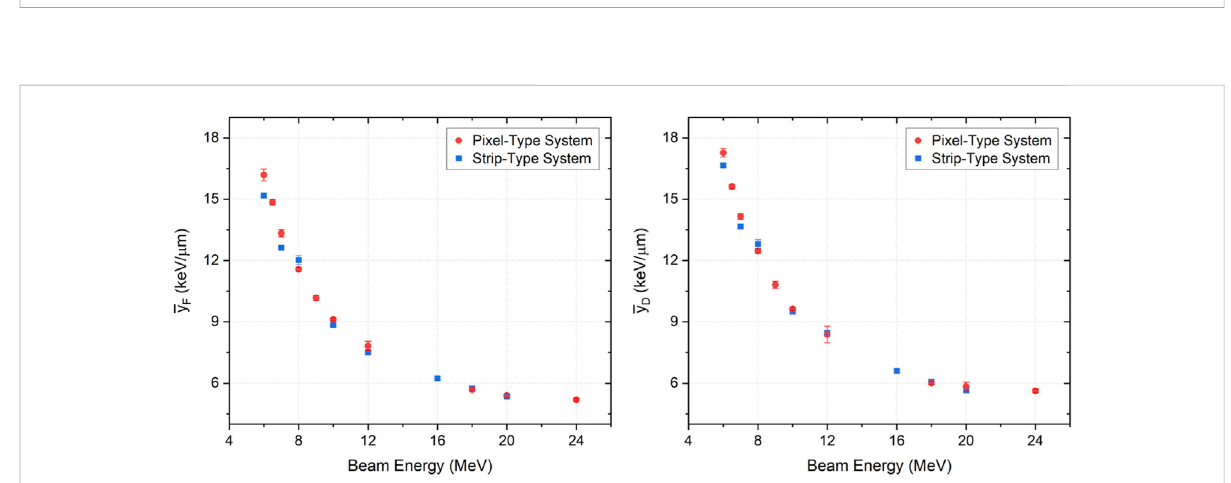
FIGURE 12 Mean values of (cid:1) y F and (cid:1) y D obtained with both systems for beam energies ranging between 6 and 24